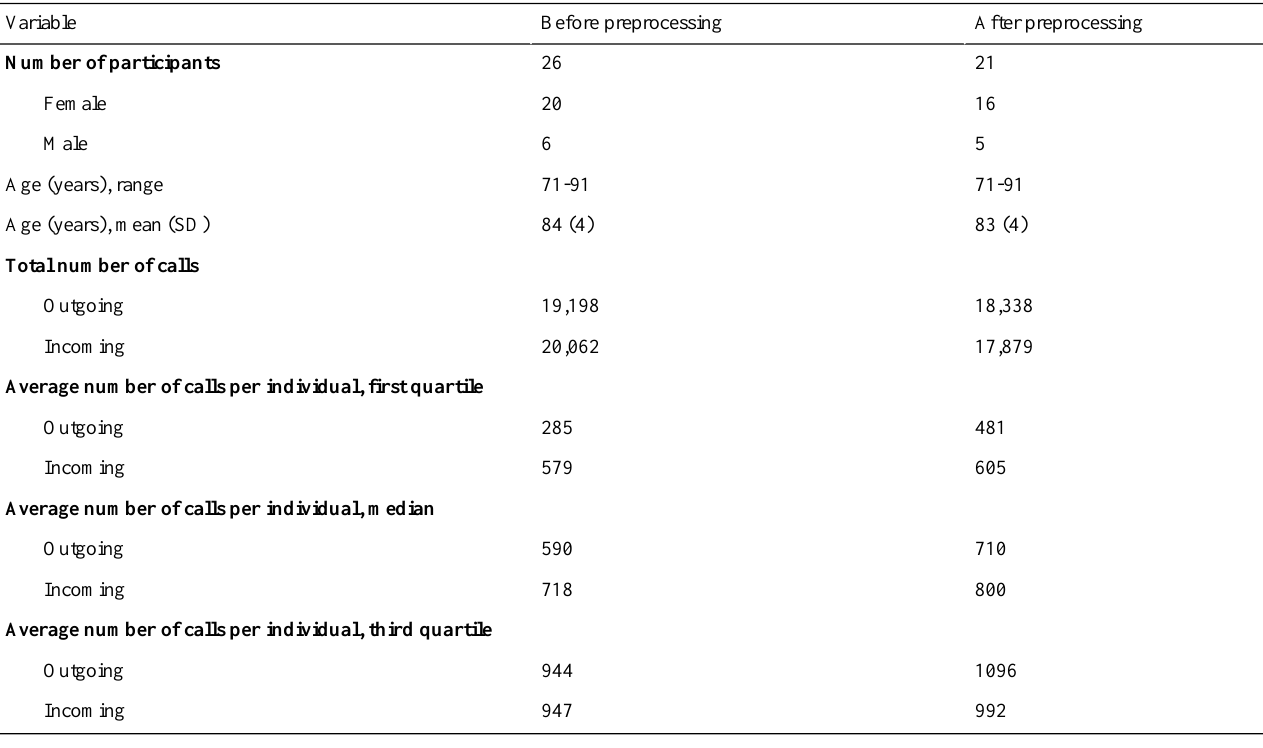
Table 1. Structure of the data set of call detail records before and after preprocessing.